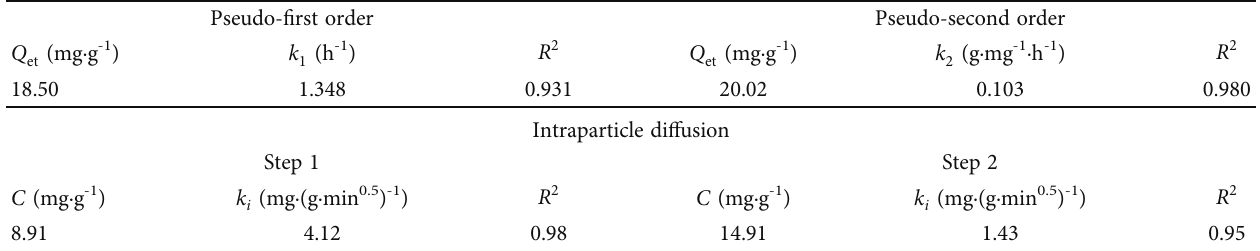
Figure 9: E ff ect of contact time on the adsorption capacity of SP-SBC for Cu(II) and fi tting results of the PFO and PSO models (a) and the IPD model (b). Table 3: Fitting parameters of three kinetic